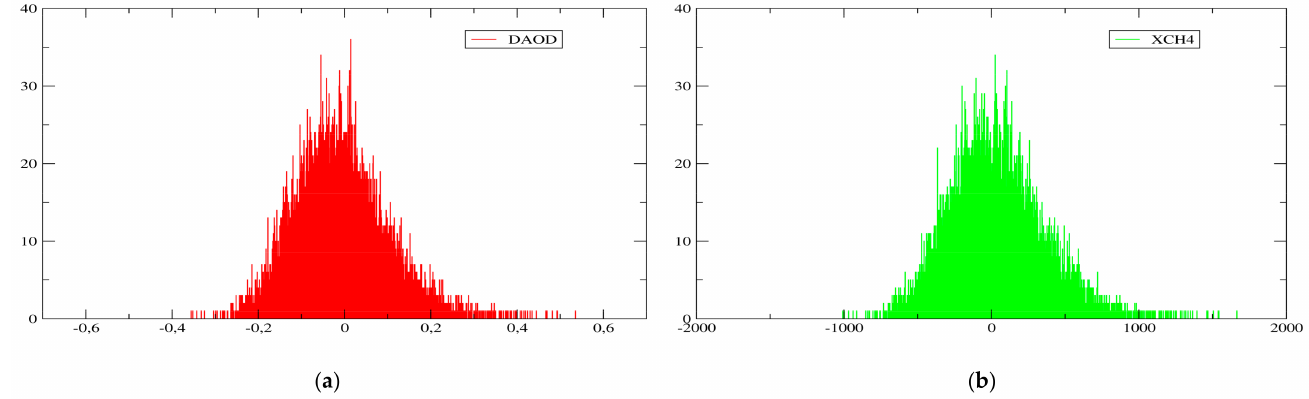
Figure 20. Histograms over 14,000 shots of the deviations from the actual values. ( a ) for the DAOD (with a sampling of 3.5 × 10 − 4 unitless). ( b ) for the XCH 4 (with a sampling of 1 ppb).